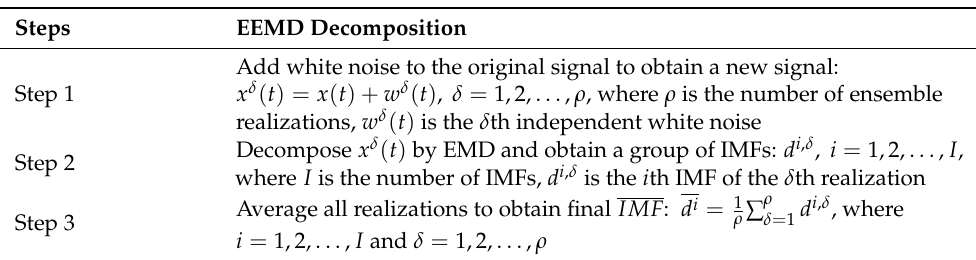
Table 2. The steps of EEMD